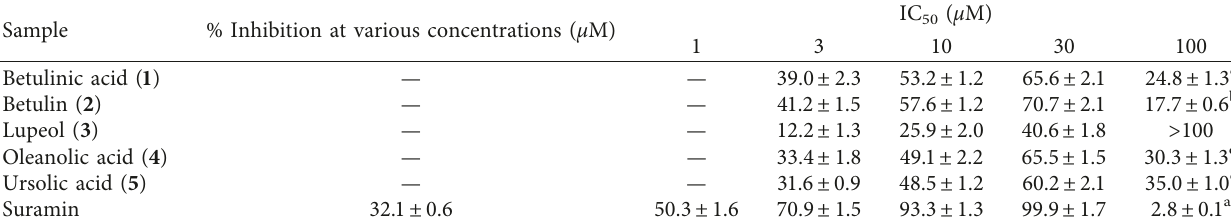
Table 2: Anti-HIV-1 integrase activity of pure compounds from B. alnoides .